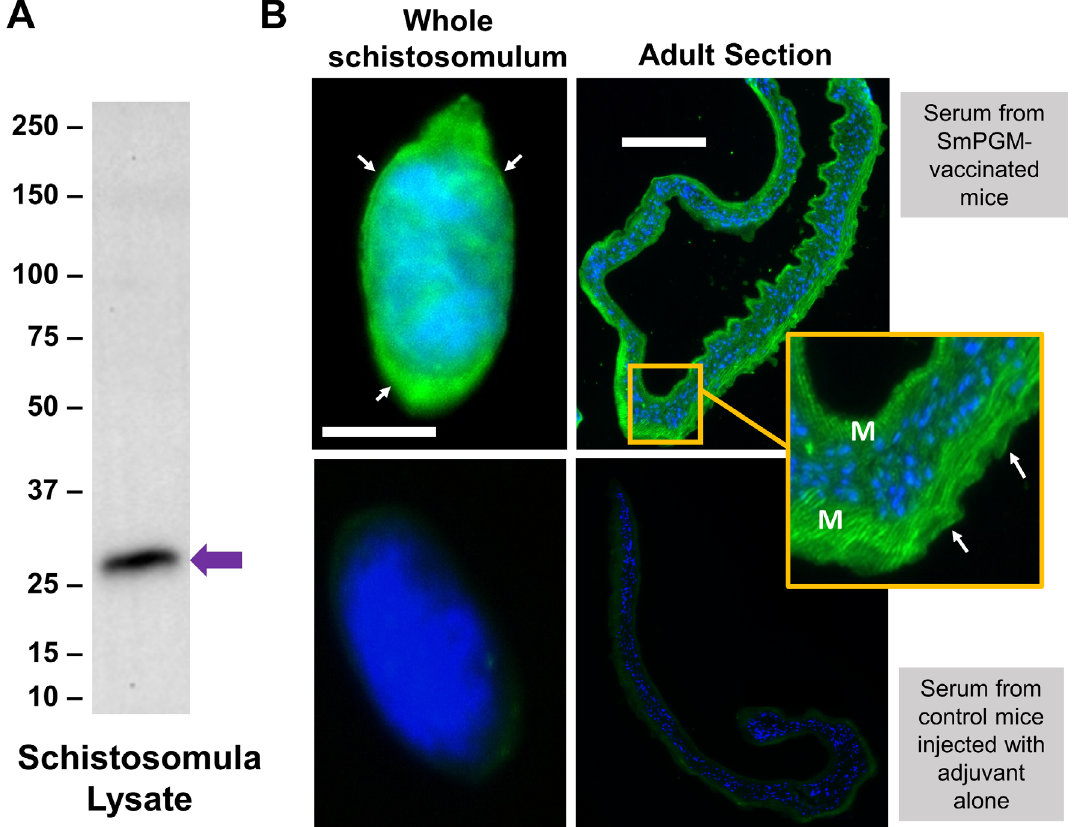
Figure 1. Immunolocalization of SmPGM in Schistosoma mansoni schistosomula and adult worms. (A) Western blot analysis demonstrating binding of antibodies from rSmPGM-immunized mice to a protein of the expected size of native SmPGM in a Schistosoma mansoni schistosomula lysate (arrow). Blots probed with sera derived from mice immunized with adjuvant alone showed no binding to parasite lysate (not shown). Numbers to the left indicate markers representing molecular mass in kDa. (B) Indirect immuno fl uorescent labeling of native SmPGM (green) in a whole fi xed S. mansoni schistosomulum (top left) and a section of an adult S. mansoni worm (top right) using sera from mice immunized with rSmPGM. Tegument staining is indicated by white arrows. Sub-tegumental muscle staining is indicated (M) in the inset yellow-bordered box. Counterstaining with DAPI highlights nuclei (blue). Lower images show a schistosomulum (left) and an adult section (right) incubated with serum from mice injected with adjuvant alone as negative controls. Scale bars: 100 l